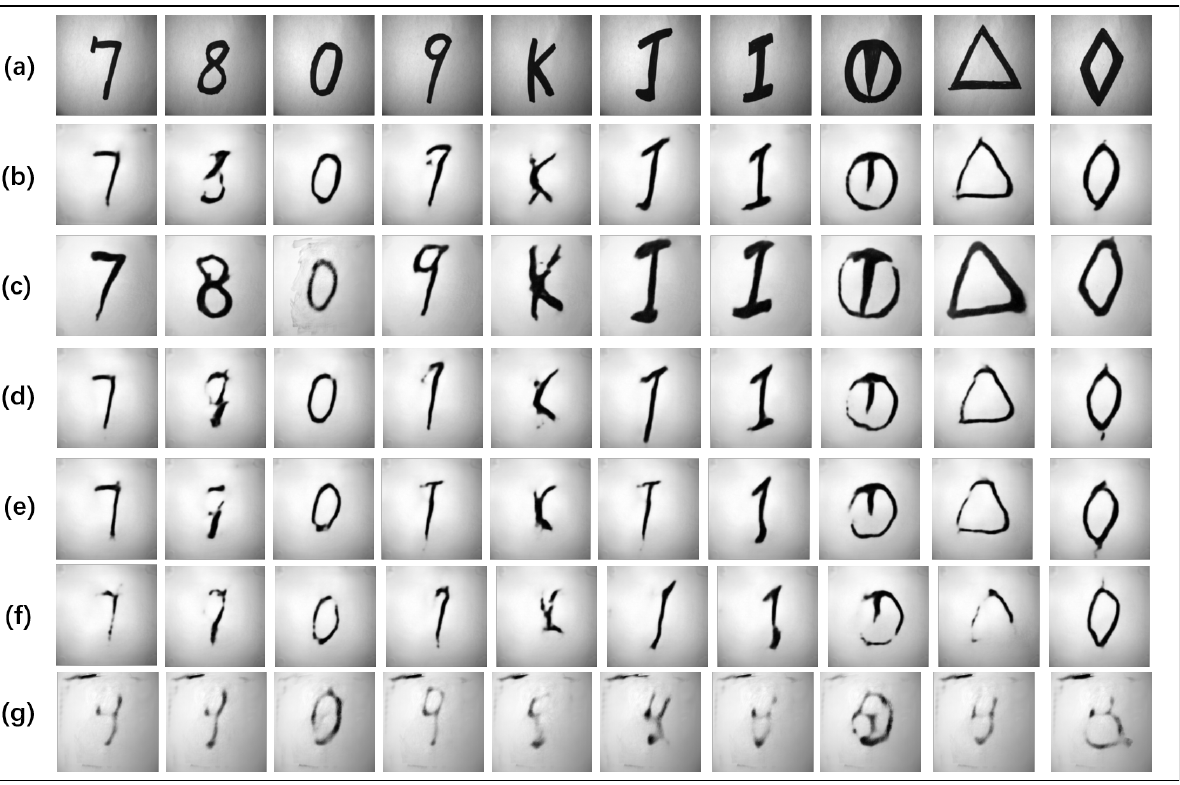
Figure 10. The reconstructed results at different imaging distances by the Model-DoP trained in the imaging distance of d = 4 cm. ( a ) Ground truth; ( b ) d = 3.5 cm; ( c ) d = 4.0 cm; ( d ) d = 4.25 cm; ( e ) d = 4.5 cm; ( f ) d = 5.0 cm; ( g ) d = 5.5 cm. Table 3. The average SSIM for the reconstructed targets in Figure 10. Different d d =